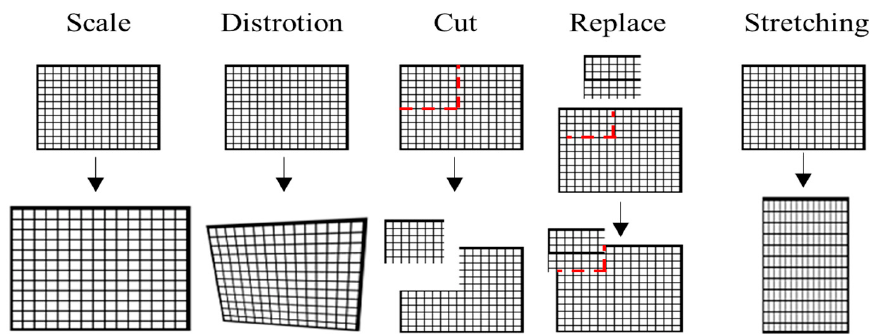
Figure 2. Examples of geometric transformation.